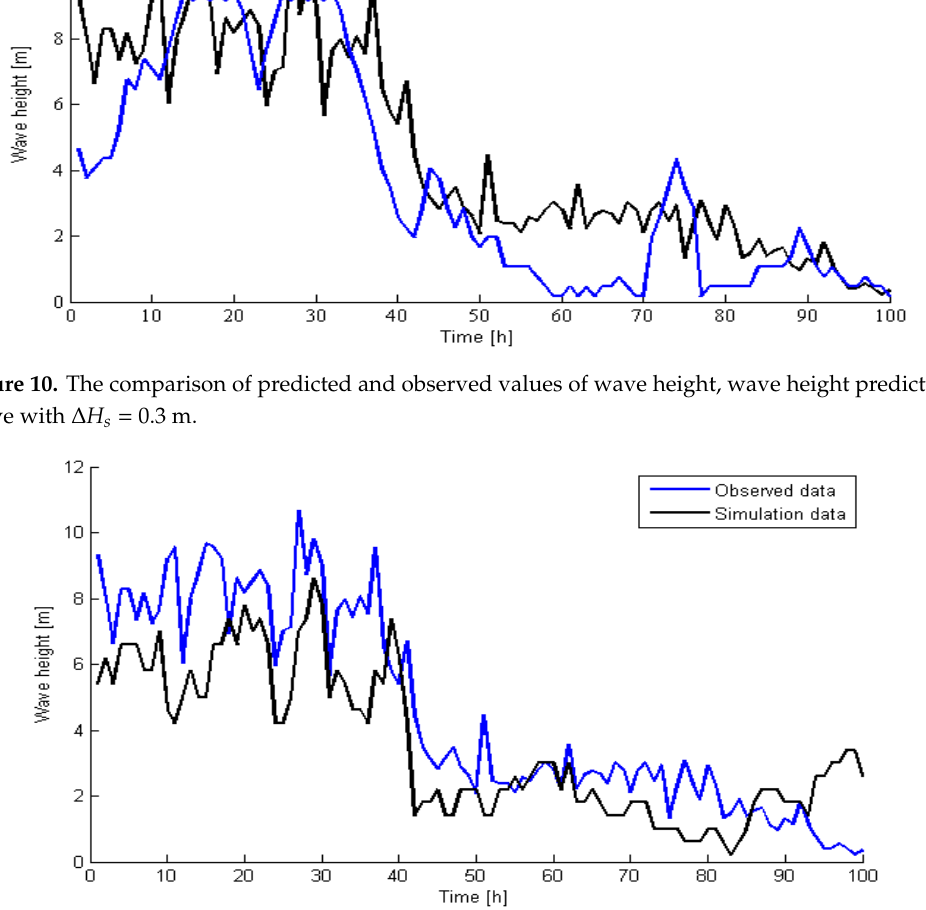
Figure 11. The comparison of predicted and observed values of wave height, wave height prediction curve with ∆ H s = 0.4 m.